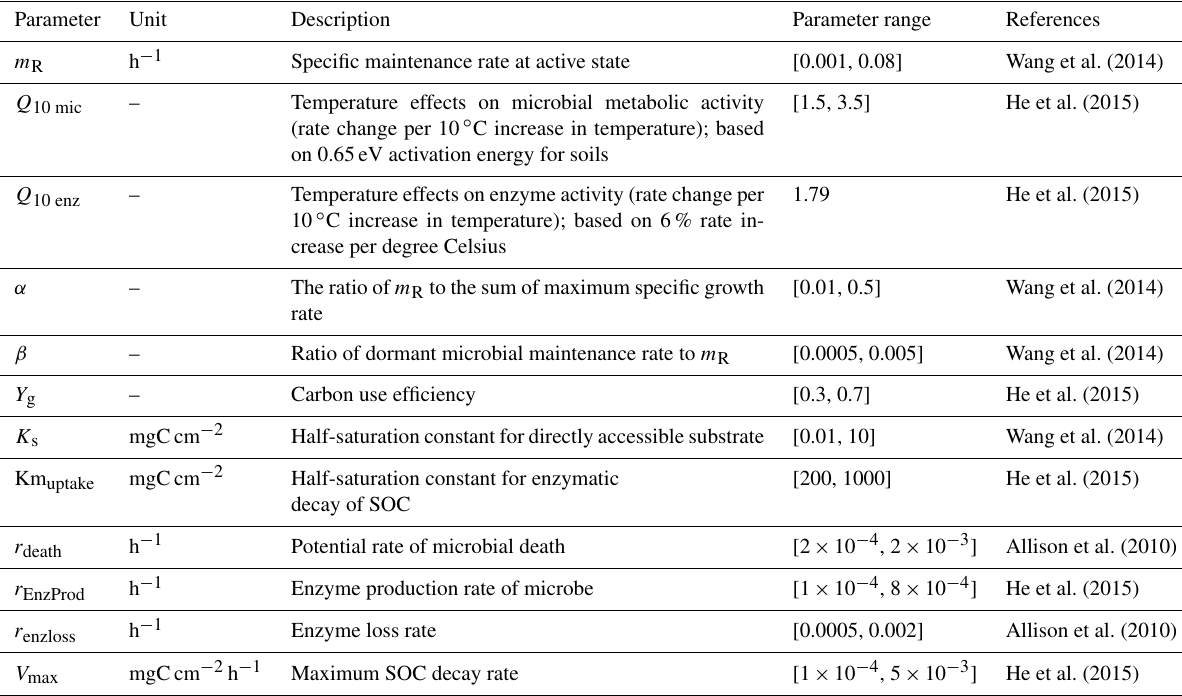
Table 1. Parameters associated with detailed microbial dormancy in MIC-TEM-dormancy.